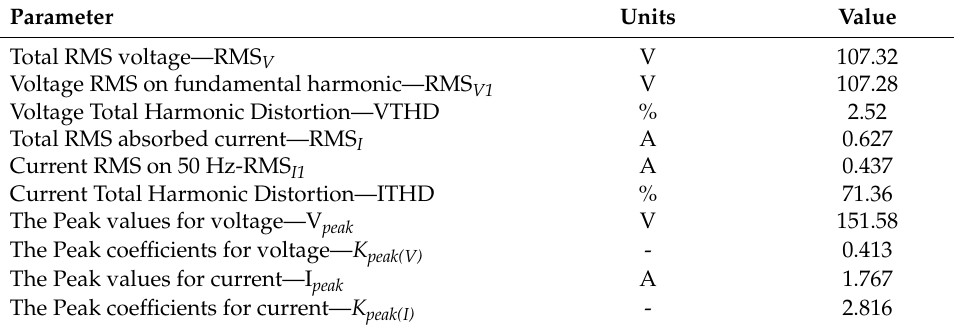
Figure 8. Harmonic spectra of the acquired signals, containing harmonic weights exceeding 1% from the component oscillating at 50 Hz, up to the maximum harmonic of 31. Table 2. Power quality parameters and indices for the recorded electric quantities for case 2.2.